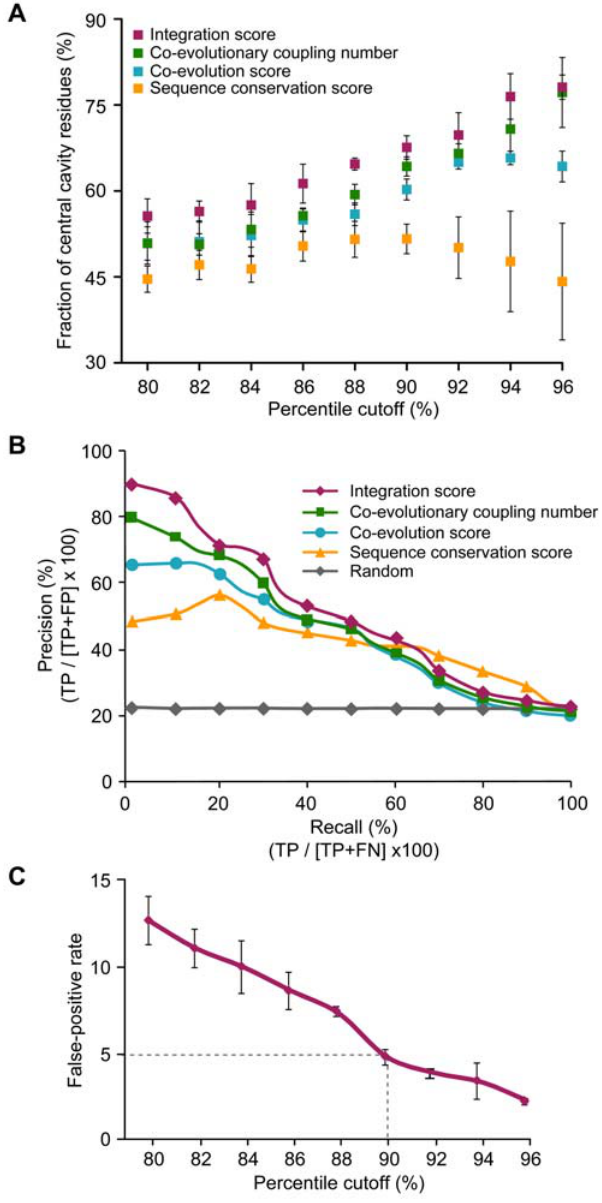
Figure2.Performancecomparisonsofthreeevolutionaryfeatures. (A) Fraction of central cavity residues at the given percentile of each evolutionary approach. Red, green, blue, and yellow squares indicate the average fraction of central cavity residues at the given percentile of IS, CN, co-evolution, and sequence conservation scores, respectively. Error bars indicate the standard deviation. (B) Precision-recall curves of four evolutionary approaches. Precision and recall were derived from cavity residues (positive set) and non-cavity residues (negative set) of three MFS transporters. Red, green, blue, and yellow dots represent the average precision of each evolutionary approach in the given recall. (C) Optimization of the percentile cutoff of IS. False-positive rates of IS were shown at the given percentile cutoffs. The dashed line indicates the percentile cutoff of IS with 5% false-positive rate. Error bars indicate the standard deviation between false-positive rates of three different MFS transporters.